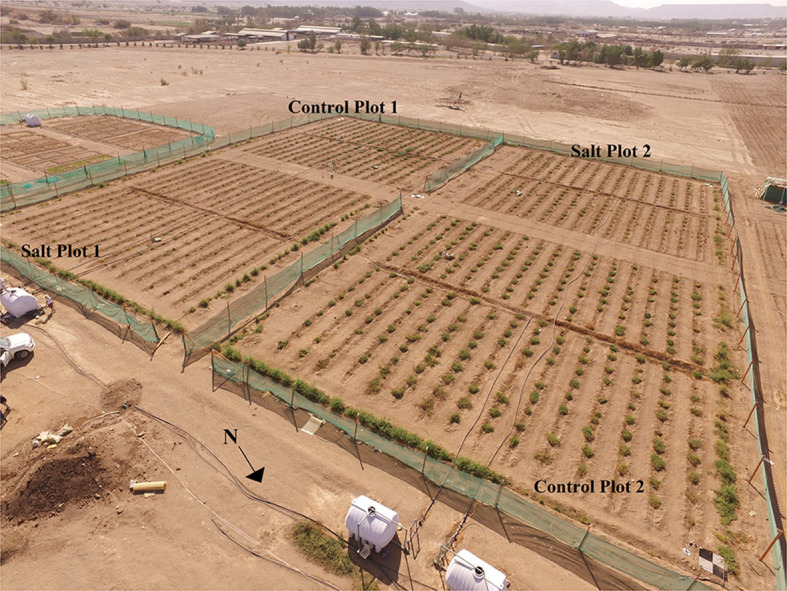
Setup of the tomato plant trial with 300 plants in each of the two control and two salt-treated plots. The plant trial covered an area of ~75 × 75 m, with each plot of 300 plants being 30 × 30 m.